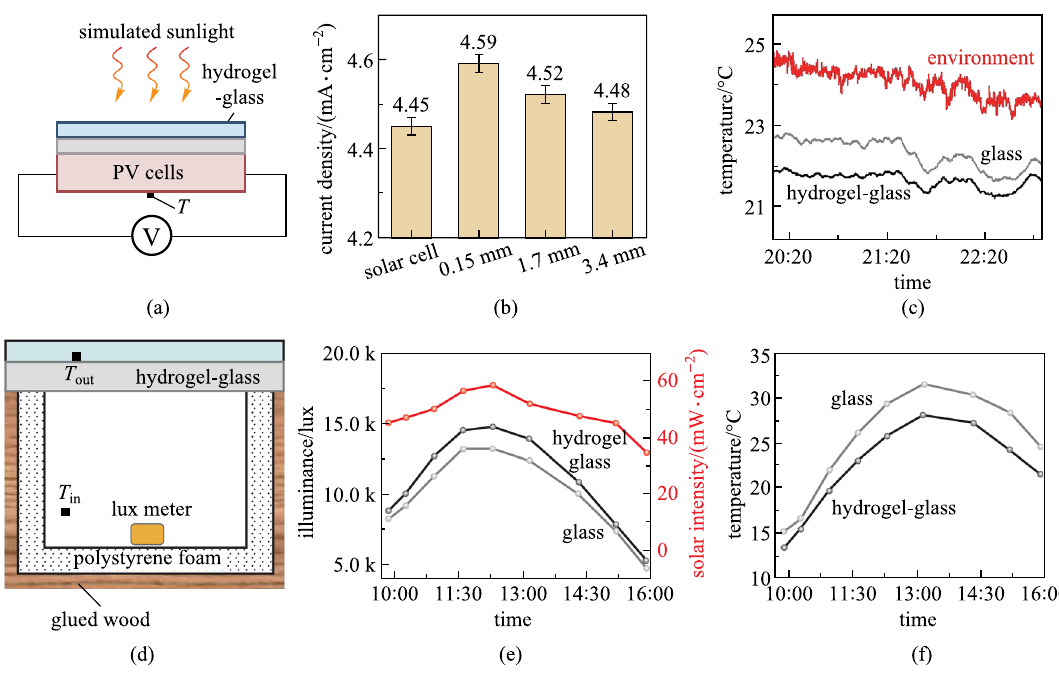
Fig. 3 Demonstrations of the broadband light management performance of the hydrogel-glass. a Schematic of the solar cell with hydrogel- glass. b Current density of the solar cell with different thickness of hydrogel layers. c Temperatures of the solar cell, solar cell with hydrogel- glass and environment from 20:00 to 23:00 at outdoor (May 21, 2021 in Wuhan, China). The relative humidity was ~ 70%. d Schematic of a house with a piece of hydrogel-glass as the window. Here, the 3-mm-thick hydrogel was used due to its high NIR absorption. e Illuminance inside the house with the hydrogel-glass and common glass in a sunny day (Jan. 1st, 2022). f Indoor temperatures inside the houses with hydro- gel-glass and common